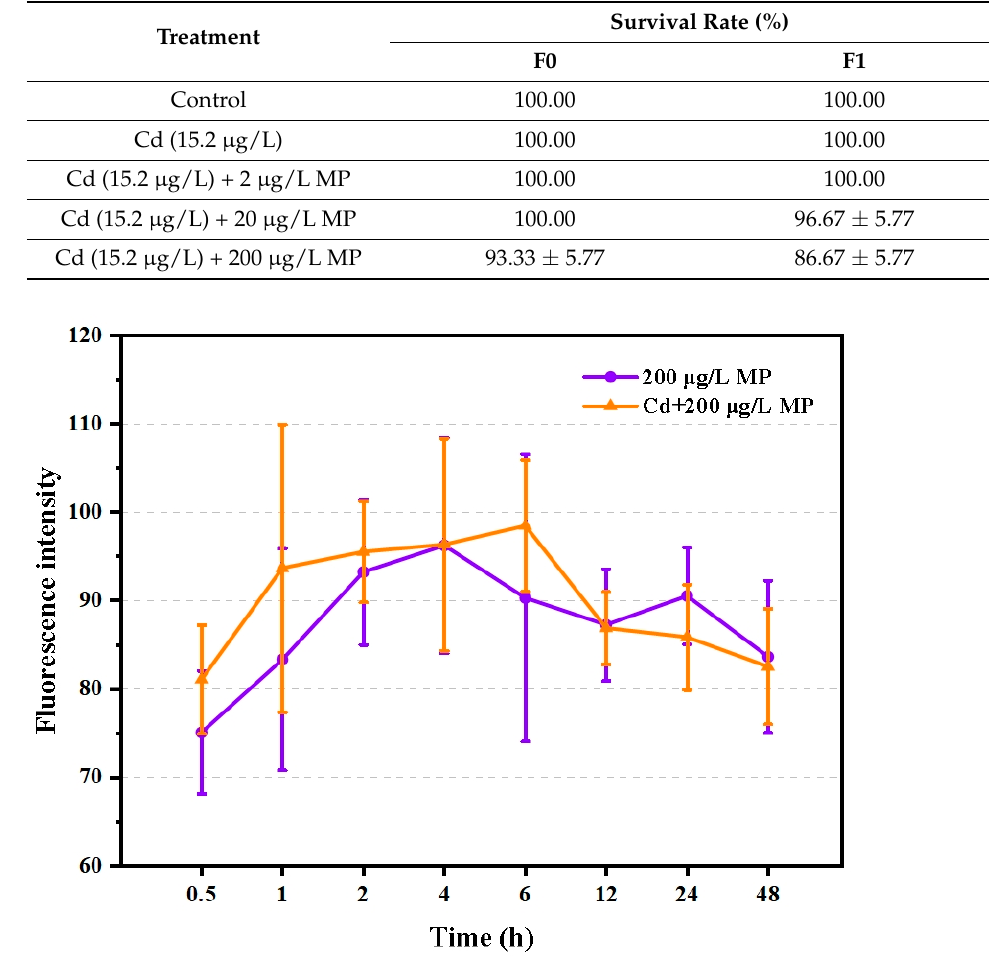
Figure 1. Fluorescence intensity of T. japonicas (F0 generation) exposure to single PS-microplastic and co-exposure with Cd ( n = 6).